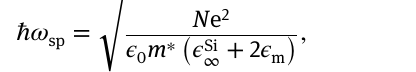
Figure 4a depicts the maximum of extinction versus N (black dots) extracted from Figure 3c. As a reference, we plot in dashed line, on the same graph, the expected LSPR energy 𝜔 (Mie resonance) for a spherical NC sp